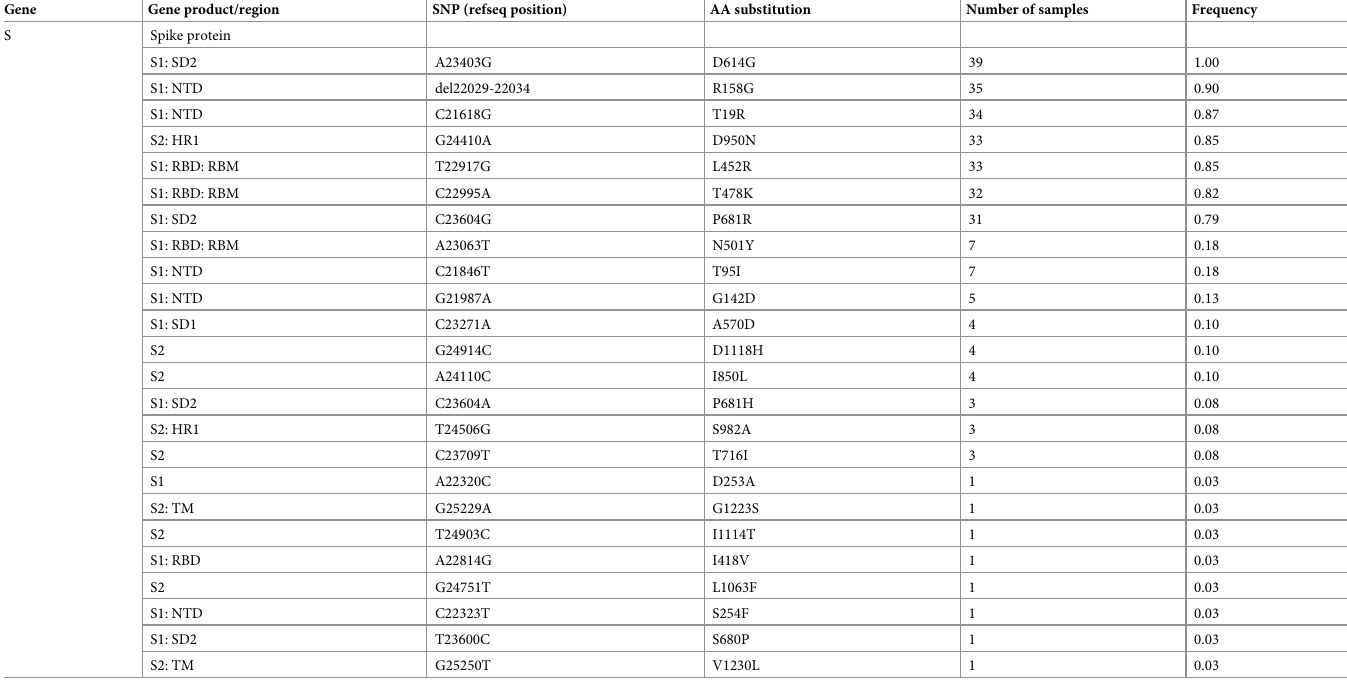
belong to the tree clades: 20A (Alpha, V1), 20I (Alpha, V1), and 21A (Delta) in consonance with “Nextstrain”‘s nomenclature system [16]. Neighbor Joining analysis and the “Nextstrain” classification has grouped 82% of our SARS-CoV-2 sample genome sequences into the Delta variant clade (n = 32; 82%), followed by Alpha (n = 4; 10.3%) and 20A (n = 3; 7.7%) clades (Figs 6 and 7).